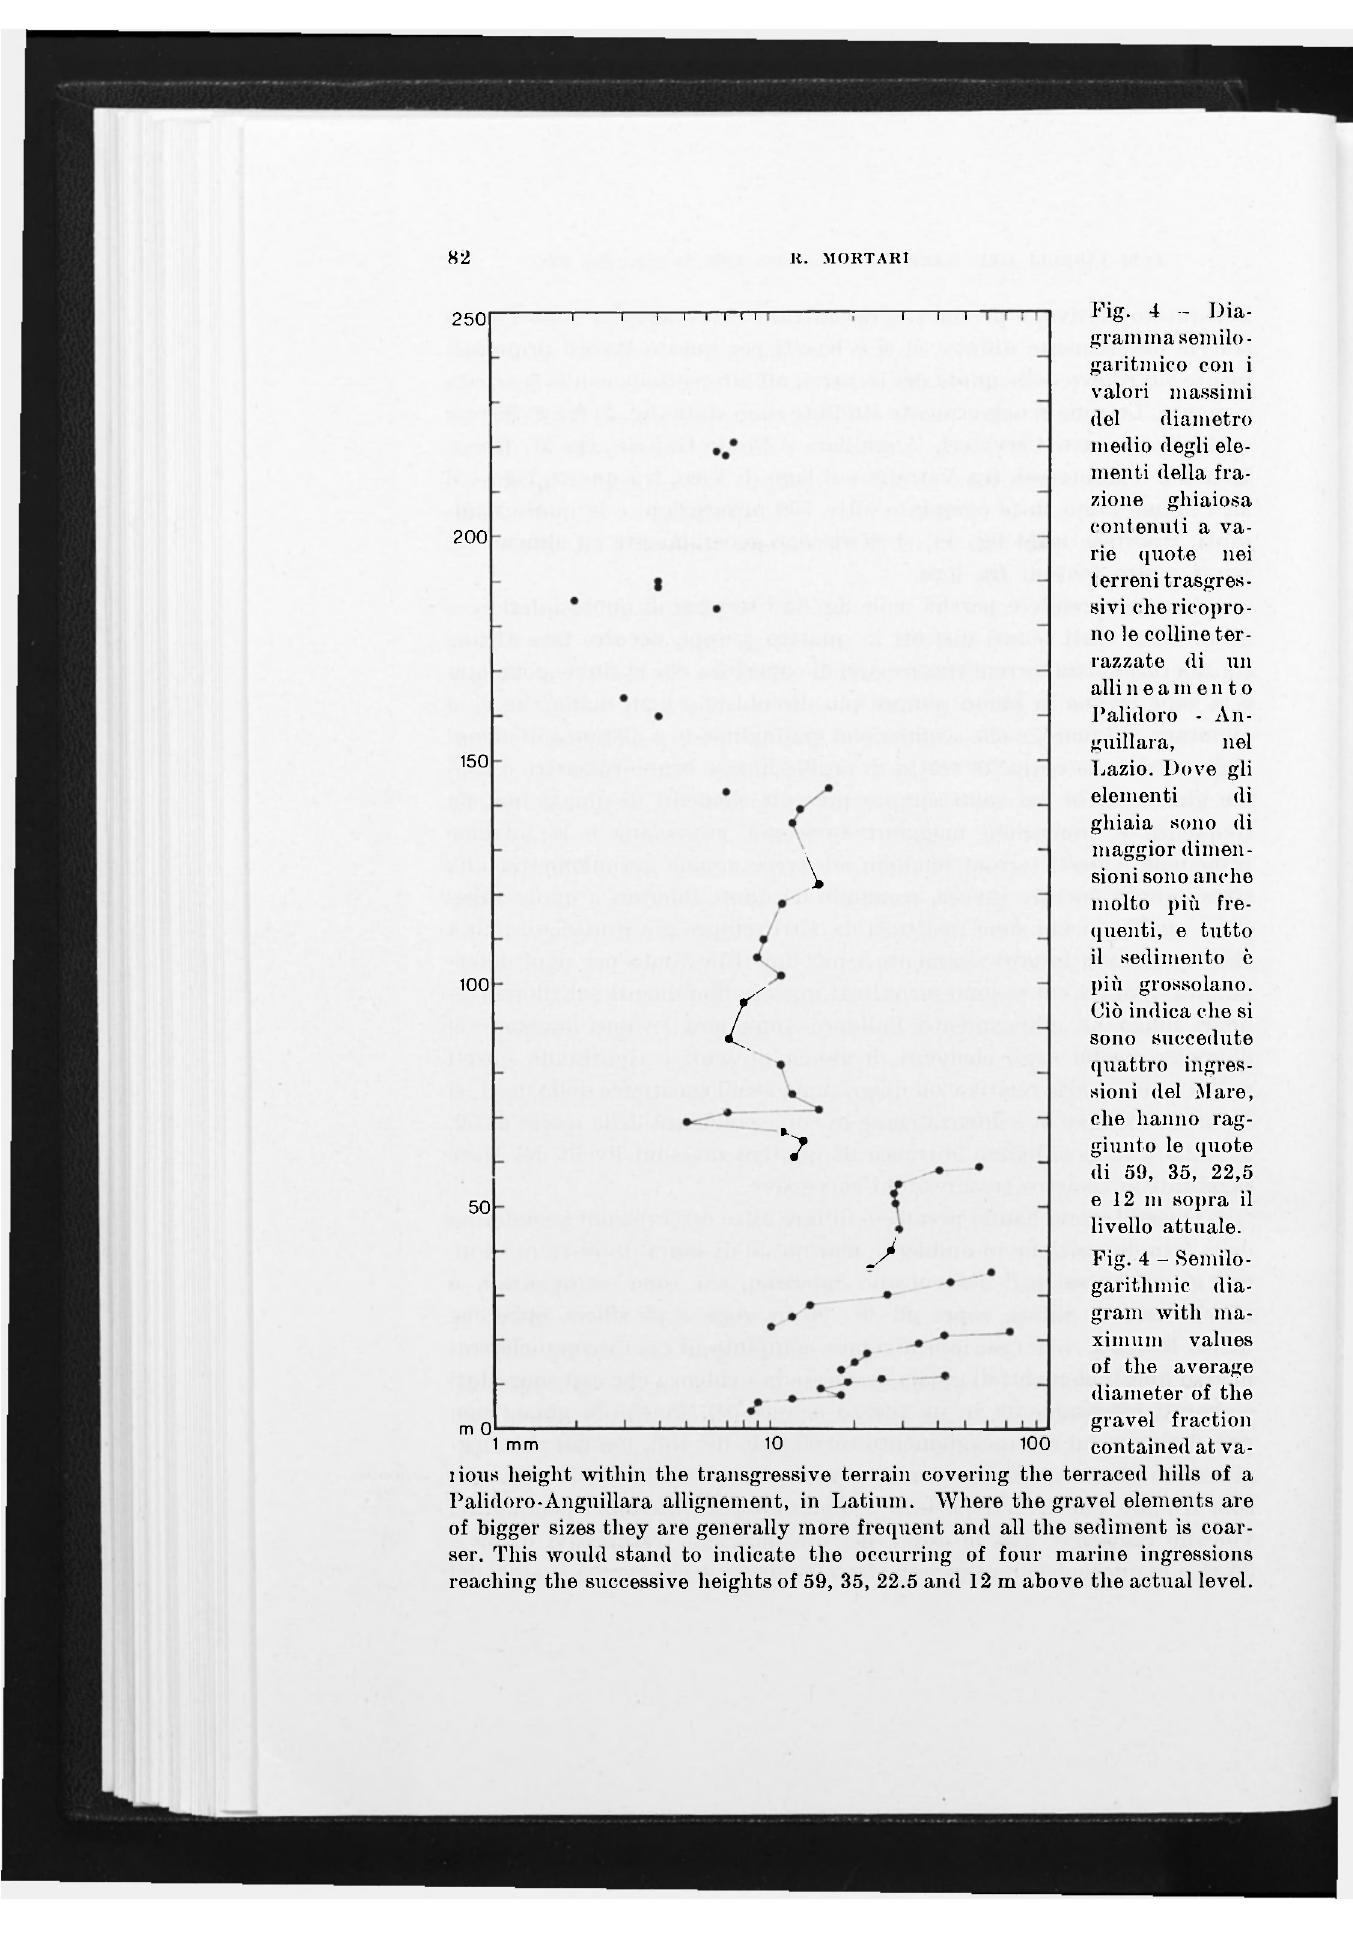
lions height within the transgressive terrain covering the terraced hills of a Palidoro-Anguillara allignement, in Latium. Where the gravel elements are of bigger sizes they are generally more frequent and all the sediment is coar- ser. This would stand to indicate the occurring of four marine ingressions reaching the successive heights of 59, 35, 22.5 and 12 m above the actual